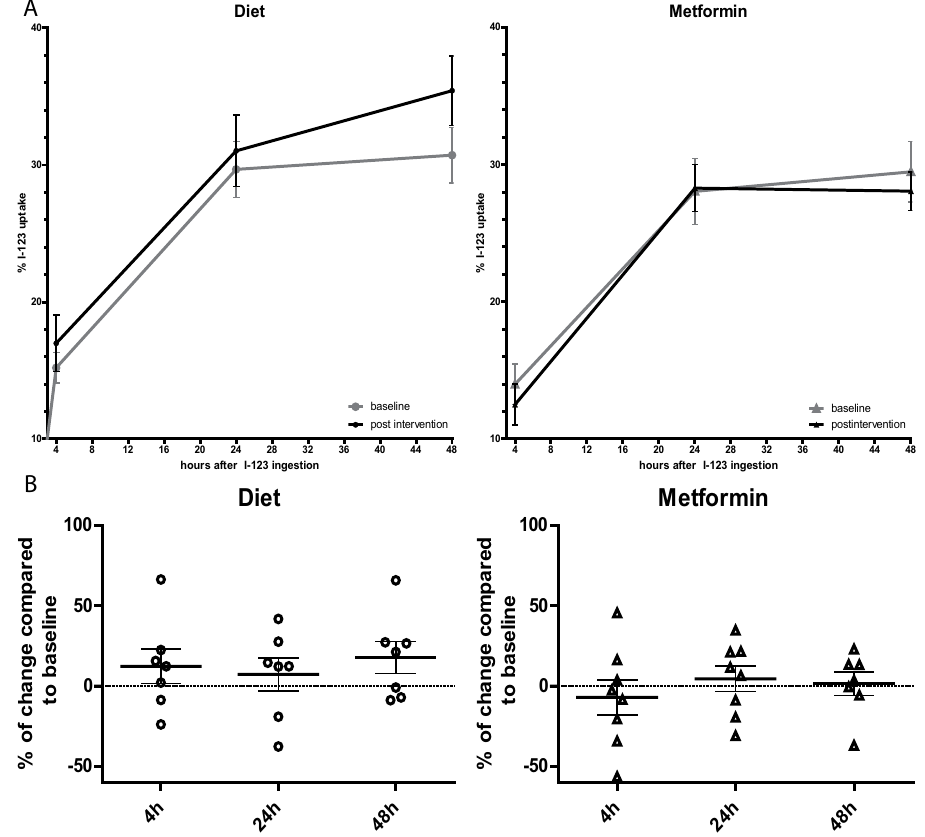
Figure 2. Effects of hypocaloric dieting and metformin on thyroid iodine-123 (I-123) uptake. Panel A shows the I-123 uptake at 4 hours, 24 hours and 48 hours after ingestion at baseline and after intervention. Panel B shows the percentage of change in I-123 uptake compared to baseline measurements at the three different time points for each intervention. Values are depicted as mean ±